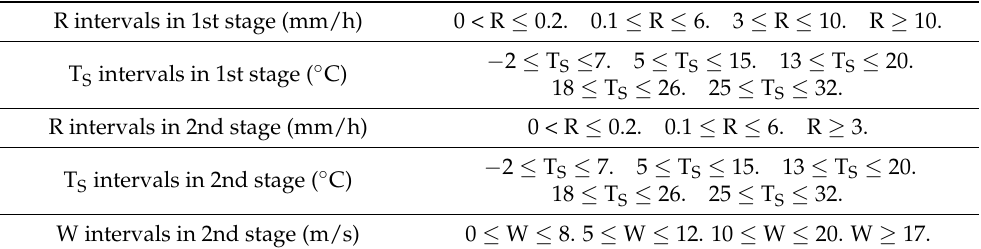
Table 3. Intervals of rain Rate R, SST T S , and wind speed W that are used in the training of the 1st and 2nd stages of the global all-weather wind speed algorithms. The intervals overlap and are chosen to ensure sufficient population in each